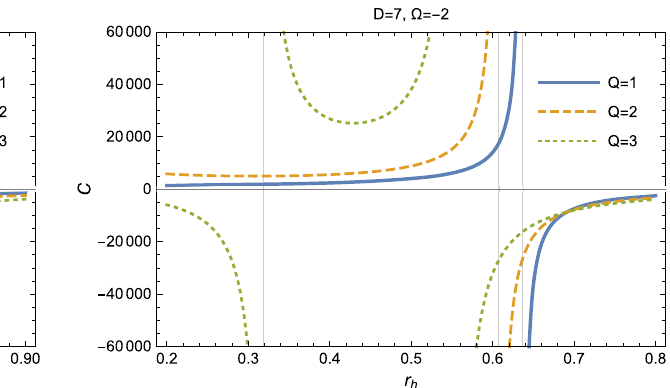
heat capacity diverges decreases as q increases while at (cid:5) = − 2, r c increases as q increases. For (cid:5) = − 2 and Q = 3 there exist two r c s in